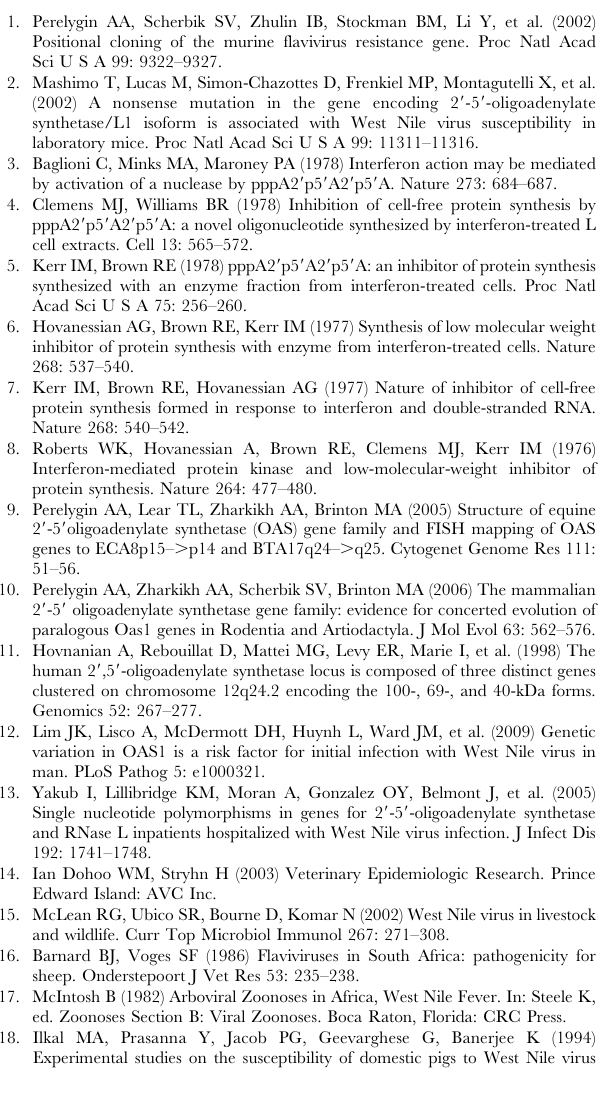
Figure S1 Local alignment of human and horse OAS1 promoters. ClustalX alignment of human (1,036 bp) and equine (1,091 bp) OAS1 promoters and 5 9 UTR. Equine OAS1